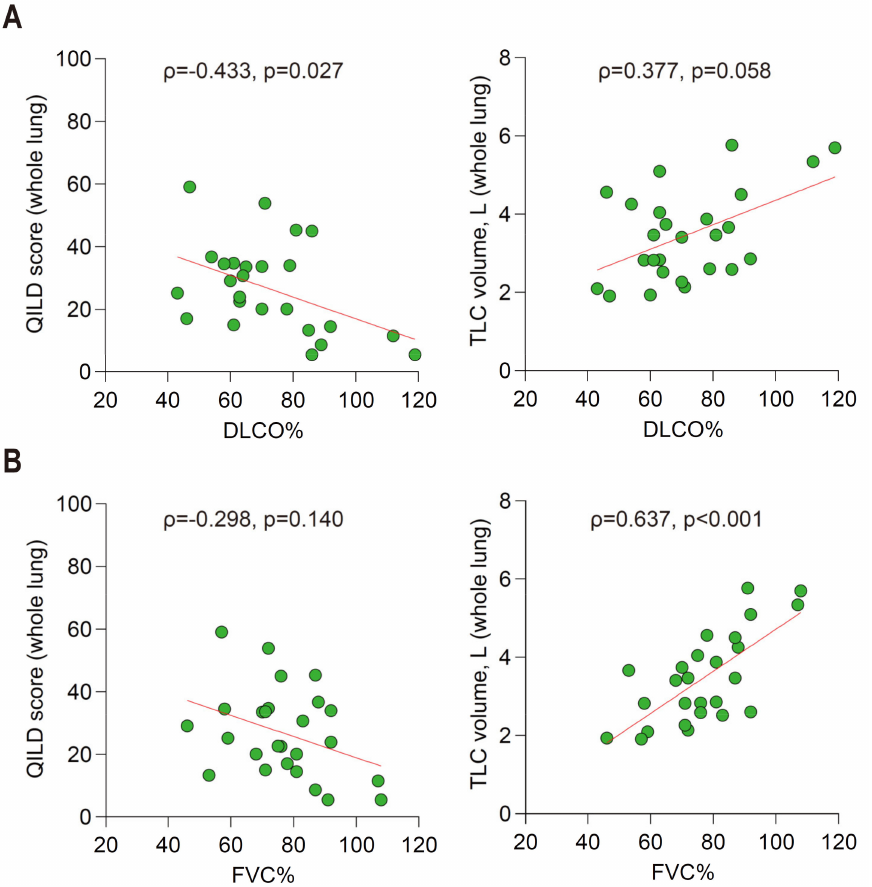
Figure 1. Quantitative correlation among QILD scores, computed total lung capacity, and the pul- monary function in the whole lung of RA-ILD patients at baseline (cohort 1). ( A ) FVC% ( B ) DLCO%. DLCO%, diffusing capacity of carbon monoxide % predicted; FVC%, forced vital capacity % predicted; ILD, interstitial lung disease; QILD, quantitative ILD score; RA, rheumatoid